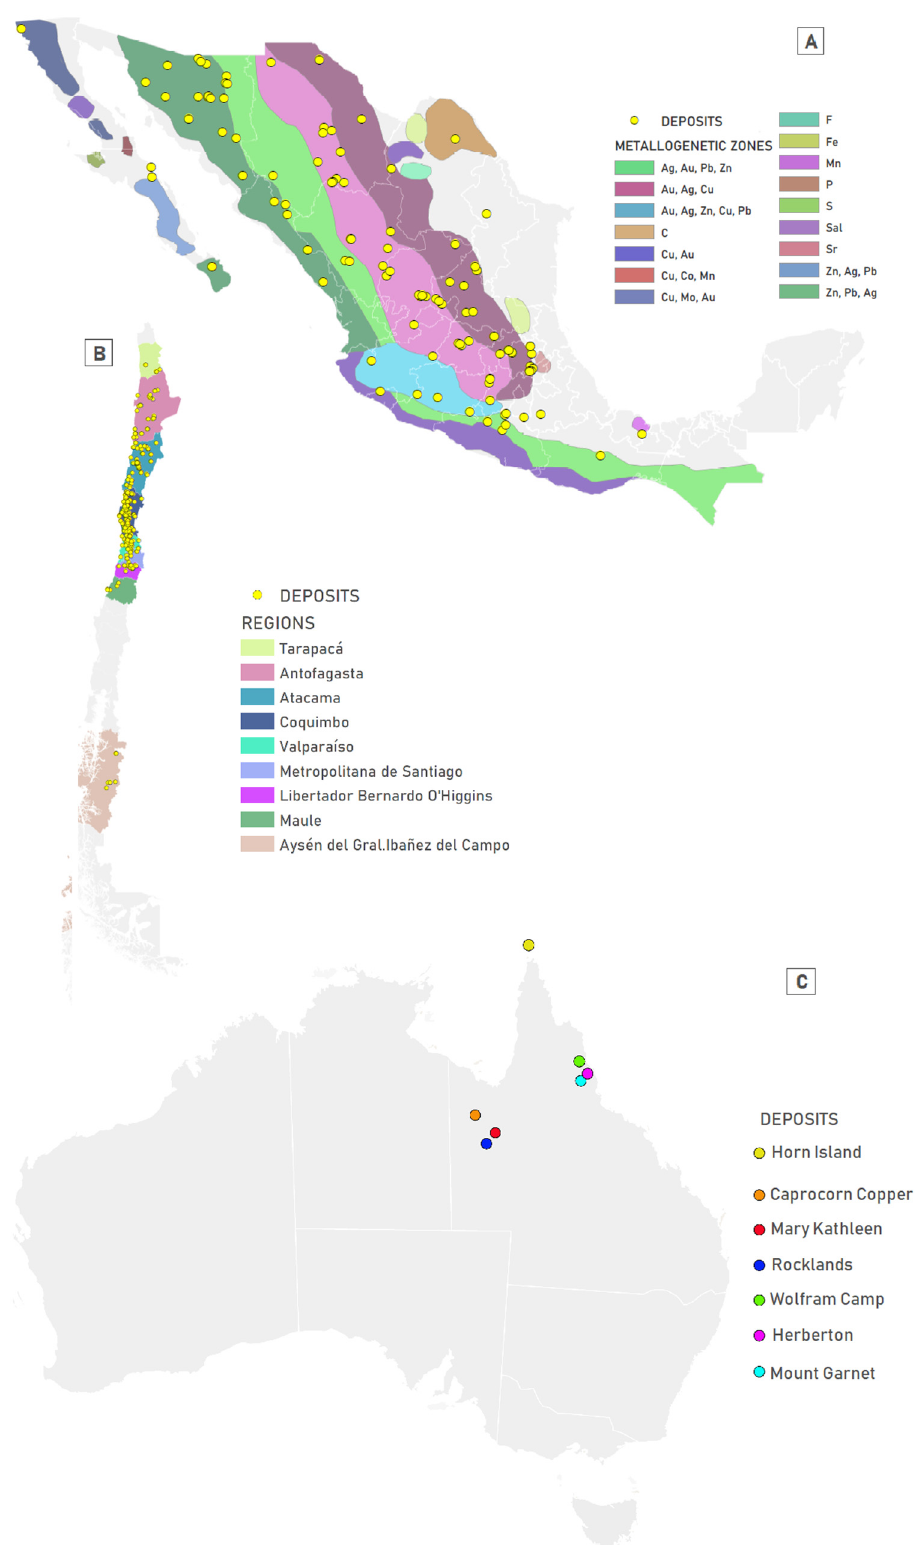
Figure 2. Spatial distribution of the data collected for ( A ) Mexico (alongside metallogenic province), ( B ) Chile (alongside regions) and ( C ) Australia.